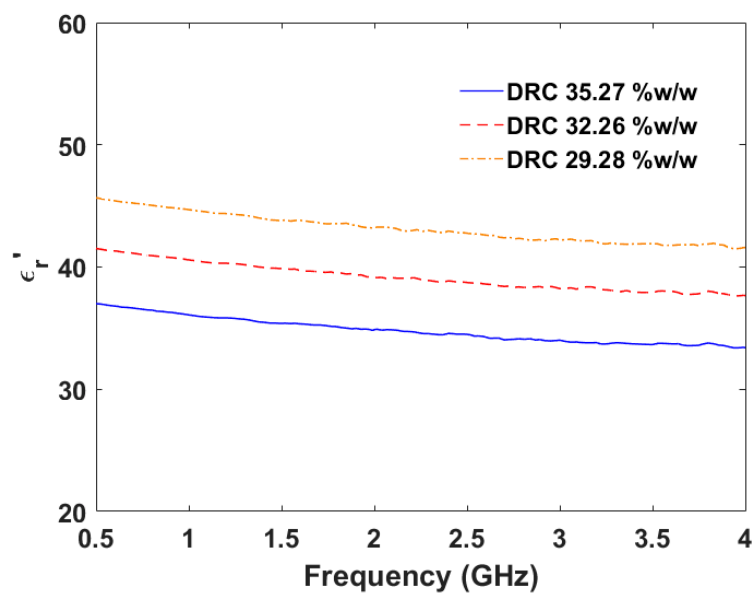
Figure 19. The real part of complex relative permittivity of natural latex samples with different DRCs in the frequency range of 0.5–4.0 GHz at the temperature of 25 °C.